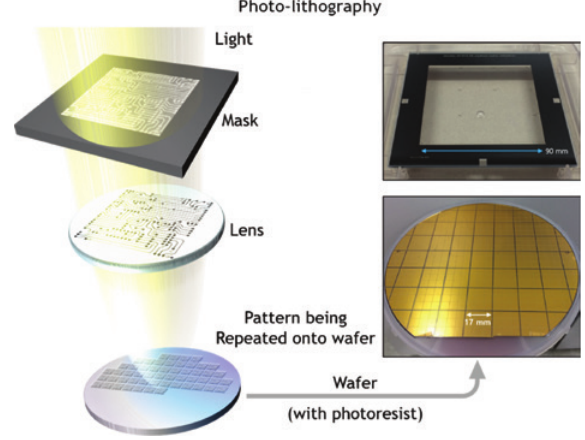
Figure 16: High-resolution and high-throughput technique for nanogap array fabrication.